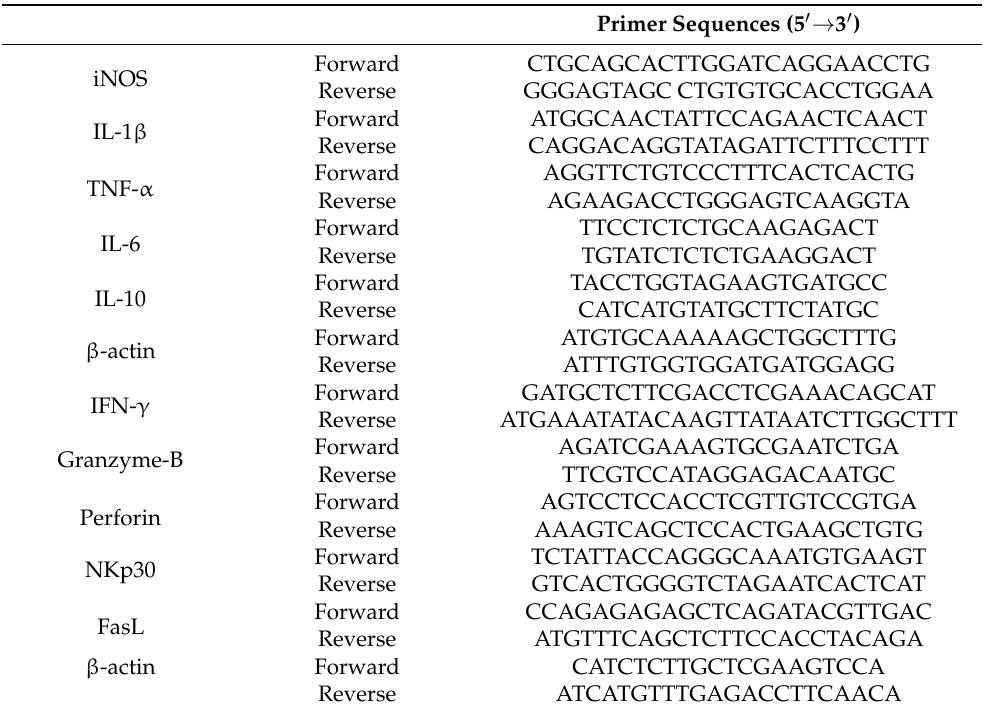
Table 1. The sequences of primers used for